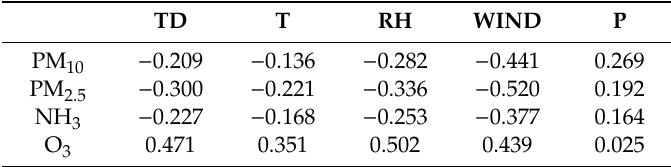
Table 2. The correlation matrix among the pollutant variables (PM 2.5 , PM 10 , NH 3 , O 3 ) and the atmospheric variables (TD, T, RH, and P) in the Italian provinces.